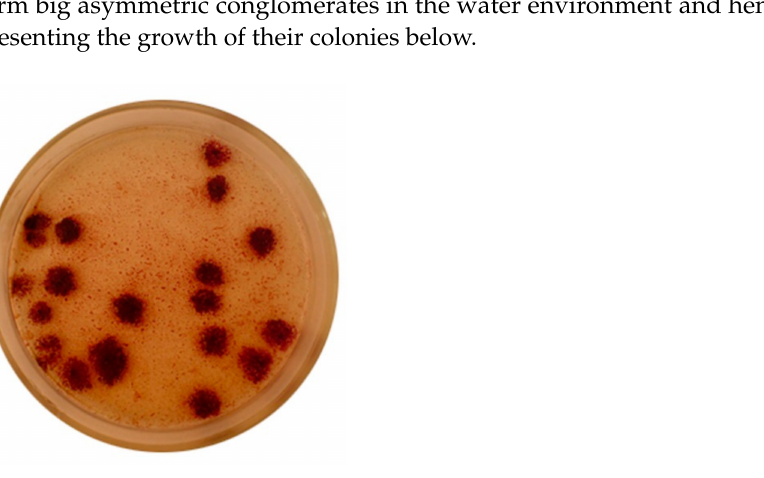
Figure 1. The colonies of purple sulfur bacteria of Lamprocystis genus